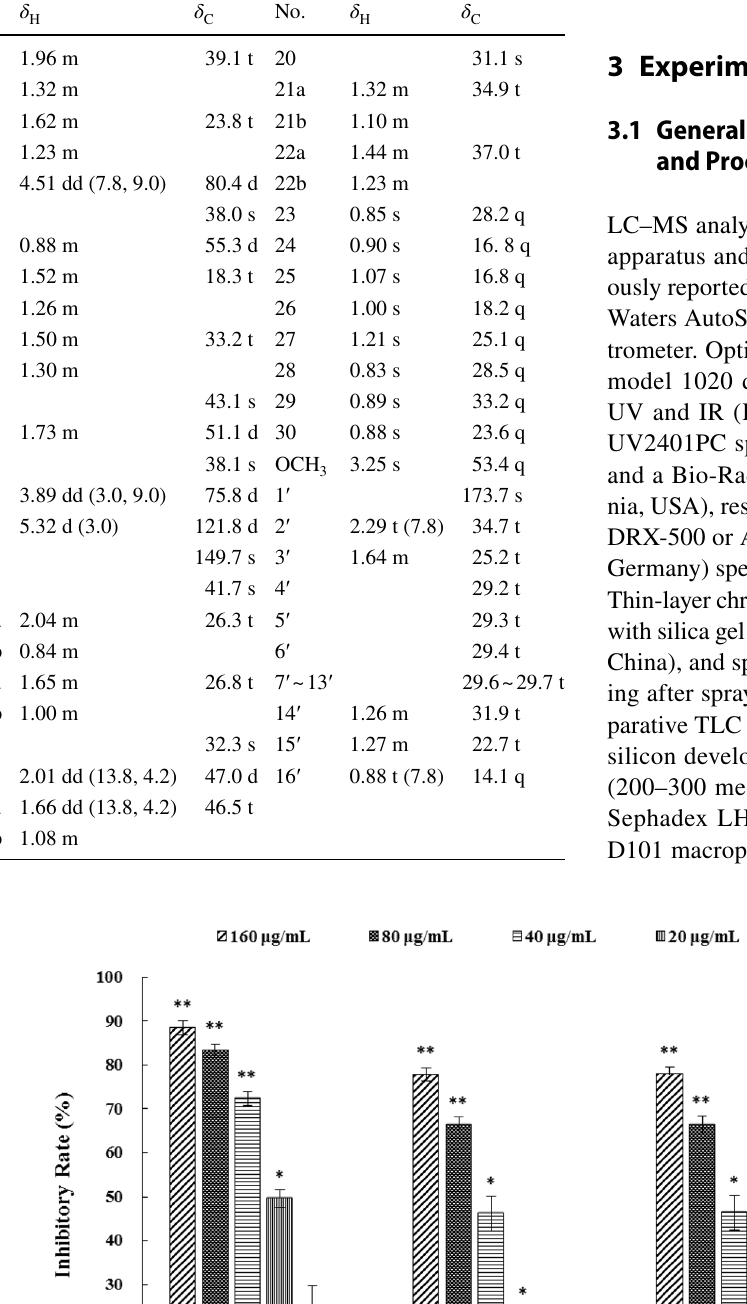
cated with one asterisk (*) (Dunnett’s one-sided t test; p < 0.05) or two asterisks (**) (p < 0.01). Error bars are one standard error of the mean. N =